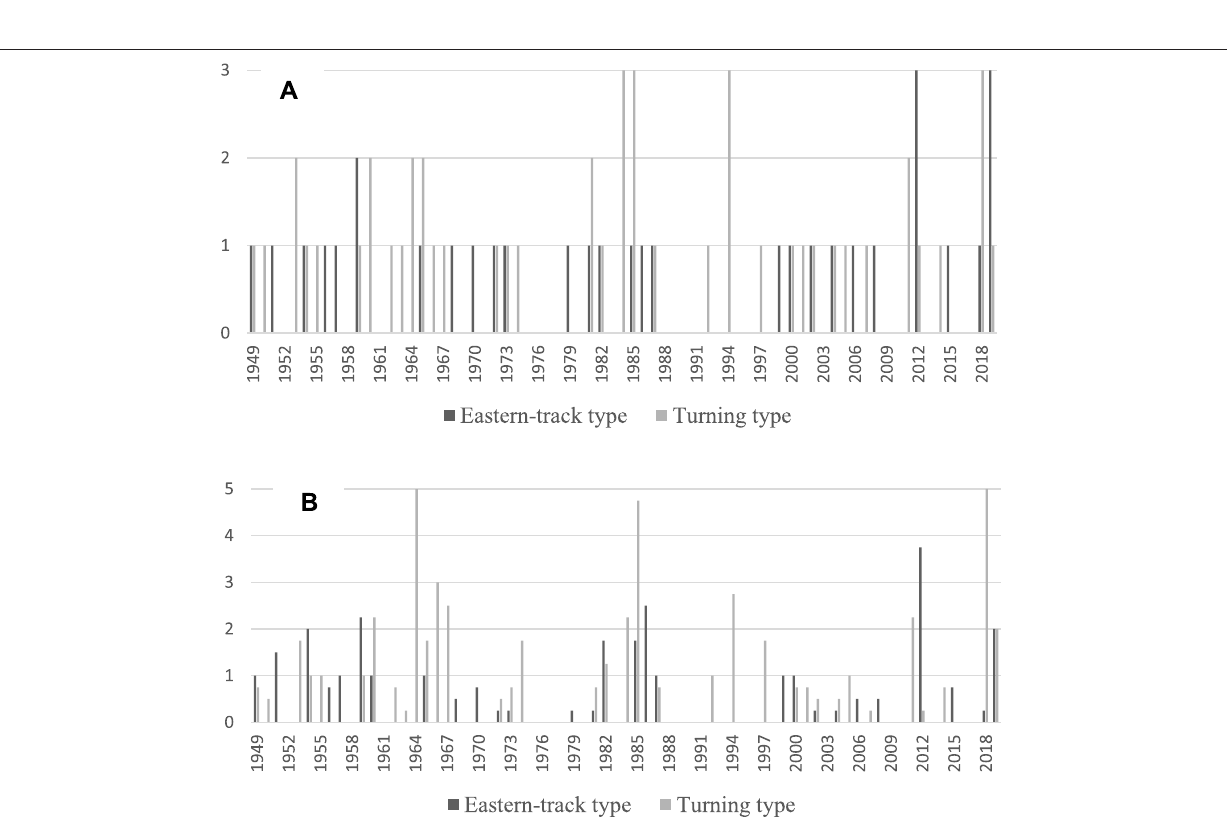
Frontiers in Earth Science |